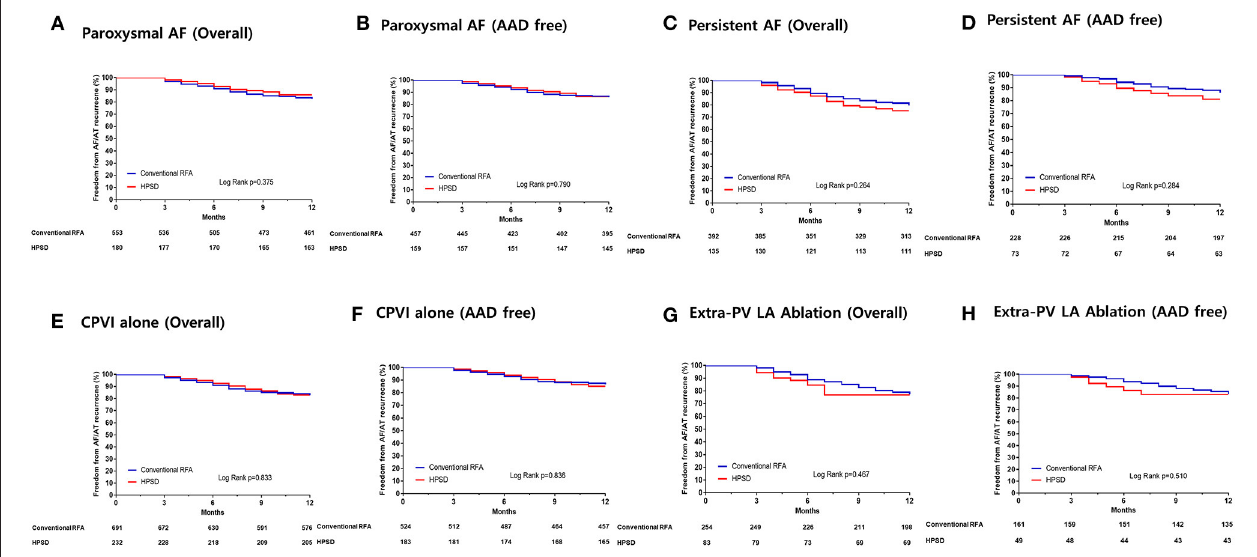
FIGURE 3 | Kaplan–Meier curves for the AF recurrence-free survival rates in the patients with paroxysmal AF (A,B), persistent AF (C,D) , who underwent circumferential pulmonary vein isolation (CPVI) alone (E,F) , and those who underwent additional extra-pulmonary vein (PV) left atrial (LA) ablations (G,H) . HPSD, high-power short-duration radiofrequency ablation; RFA, radiofrequency ablation.